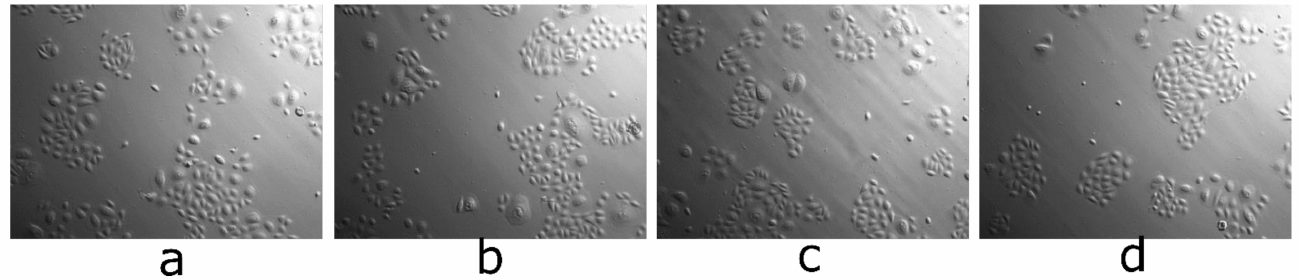
Figure 10. The impact of the tested compounds (100 uM) on cellular morphology for keratinocytes: control medium ( a ) lupeol acetate ( b ), lupeol isonicotinate ( c ) and lupeol acetylsalicylate ( d ), 100 × magnification, 36l K cells (2p), Cells were seeded 24 h before adding compounds, at the density of 5 × 10 4 cells per well of a 6-well plate, picture made after 2 h of incubation with compounds.